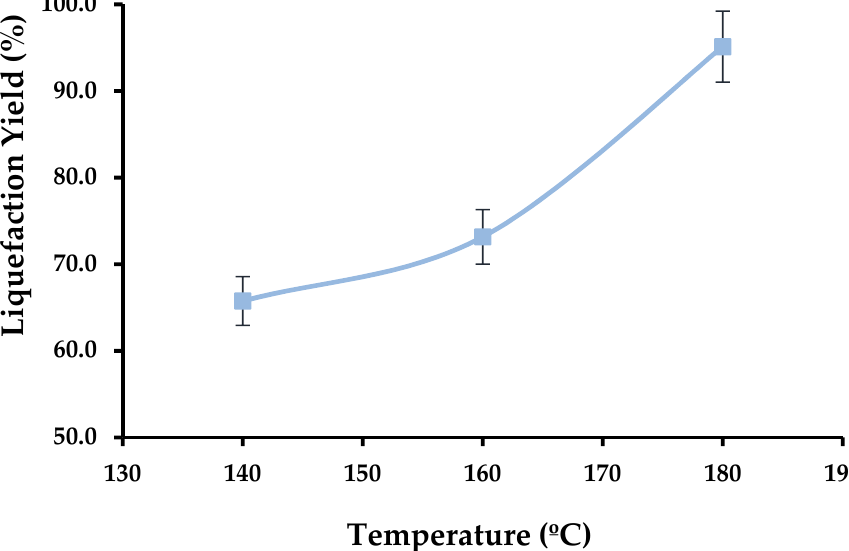
Figure 3. Study of the temperature for the samples of the branches (CsB) of Cytisus scoparius (constant parameters: time 60 min, size for the samples <80 mesh and ratio CsB:solvent of 1:10). The liquefaction yield increased with the increase of temperature liquefaction, achiev- ing a promising value of 95.1% for 180 ◦ C. At lower temperatures, the liquefaction yield was only 65% and 73.5% for 140 ◦ C and 160 ◦ C, respectively. The high percentage of liquefaction for 180 ◦ C is higher than that obtained for other materials in similar conditions, such as, for example, Eucalyptus globulus bark (61.6%) and branches (62.2%) [26]. Until 180 ◦ C, no recondensation reactions were observed, or at least it was not significant, probably due to the use of a co-solvent system by the addition of a low-molecular-weight glycol (glycerol) and ethylene glycol, as mentioned before